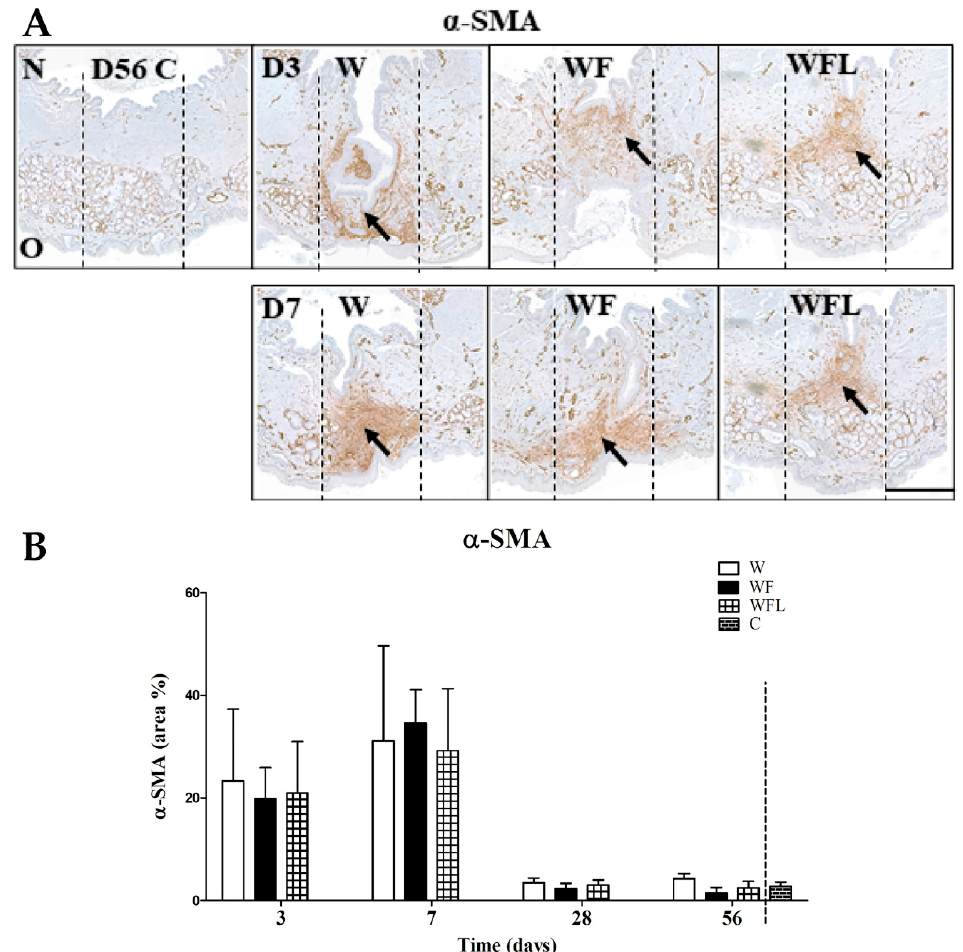
Figure 6. α -SMA immunostaining. ( A ) Representative images of the age control (C) at day 56 (D56) and the experimental groups at days 3 (D3) and 7 (D7). The age control (D56 C) at day 56 shows no staining in the central region except in small vessels and salivary glands. α -SMA expression by myofibroblasts is present mostly in the central wound regions and it seems to increase in all wounds from day 3 to 7. N: nasal side of the soft palate. O: oral side of the soft palate. The arrows indicate α -SMA expression in the wounds. The vertical black lines indicate the central region of 700 µ m. The lateral regions of 500 µ m are next to it. Scale bar is 500 µ m. ( B ) Quantification of the staining. The stained areas increase from day 3 to 7 ( p < 0.05) without differences between the groups. By days 28 and 56 the stained areas in all experimental groups had decreased ( p < 0.05) without differences with the control wounds. Data are shown as mean ± SD. The areas between experimental groups were compared in time using a two-way ANOVA and a Bonferroni post-hoc test. Comparisons between experimental groups and the age control group at day 56 were performed using a one-way ANOVA and a Bonferroni post-hoc